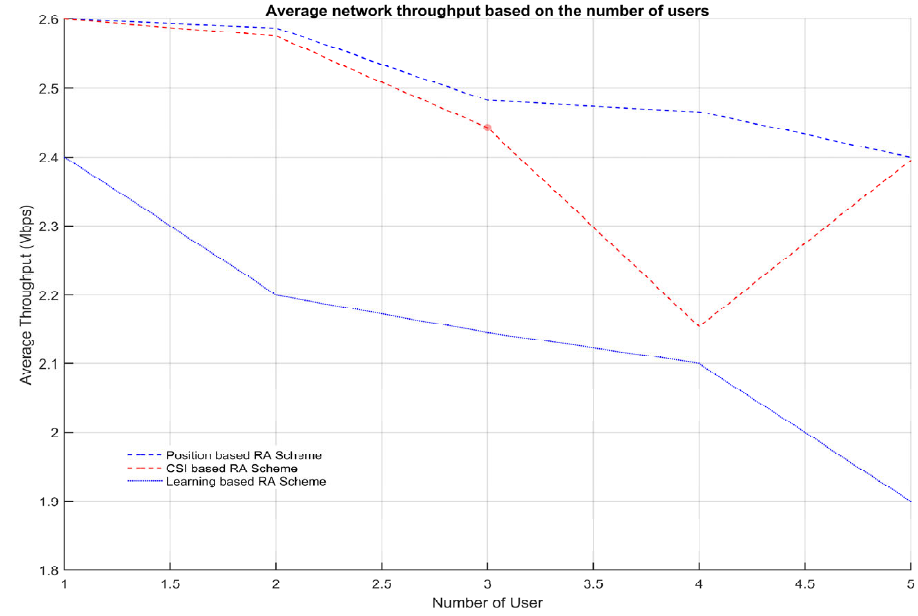
Figure 5. Average network throughput based on the number of users.